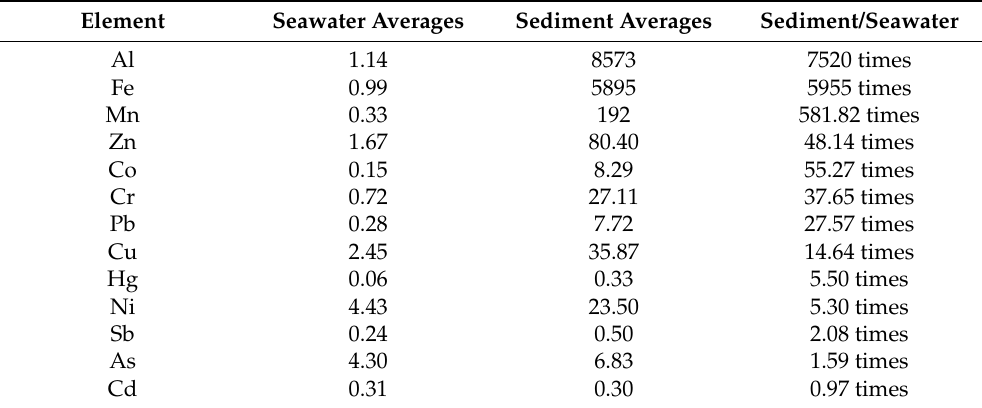
Table 3. Comparison between HMs concentration in the seawater ( µ g/L) and sediment ( µ g/g) of the study